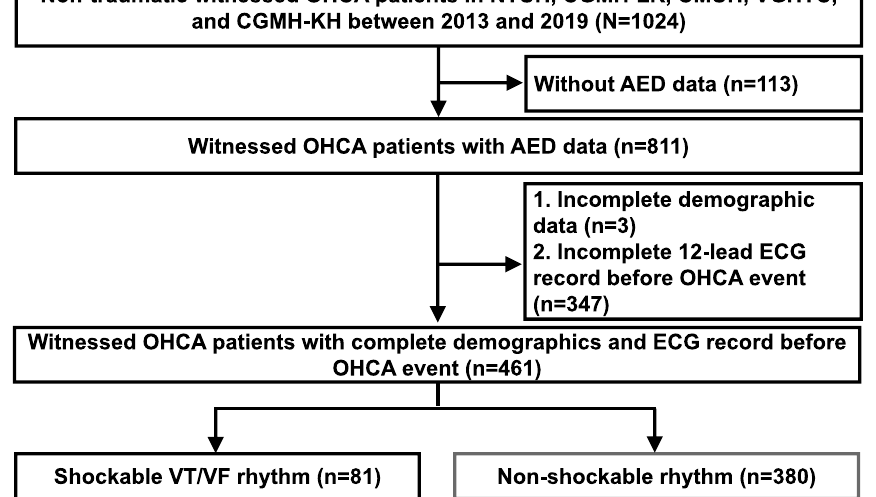
Figure 1. Flow diagram depicting the enrollment of witnessed out-of-hospital cardiac arrest (OHCA) patients. Of the 1024 witnessed OHCA patients in NTUH, CGMH-LK, CMUH, VGHTC, and CGMH-KH between January 1, 2013, and December 31, 2019, 811 patients had complete AED data. After excluding patients with incomplete demographic data (n = 3) or no 12-lead ECG records before OHCA events (n = 347), a total of 461 patients were included in the analysis. There were 81 patients with initial shockable VT/VF rhythm and 380 patients with non-shockable rhythm. AED, Automated External Defibrillator; CGMH-KH, Kaohsiung Chang Gung Memorial Hospital; CGMH-LK, Chang-Gung Memorial Hospital at Lin-Ko; CMUH, China Medical University Hospital; NTUH, National Taiwan University Hospital; VGHTC, Taichung Veterans General Hospital; VT, ventricular tachycardia; VF, ventricular